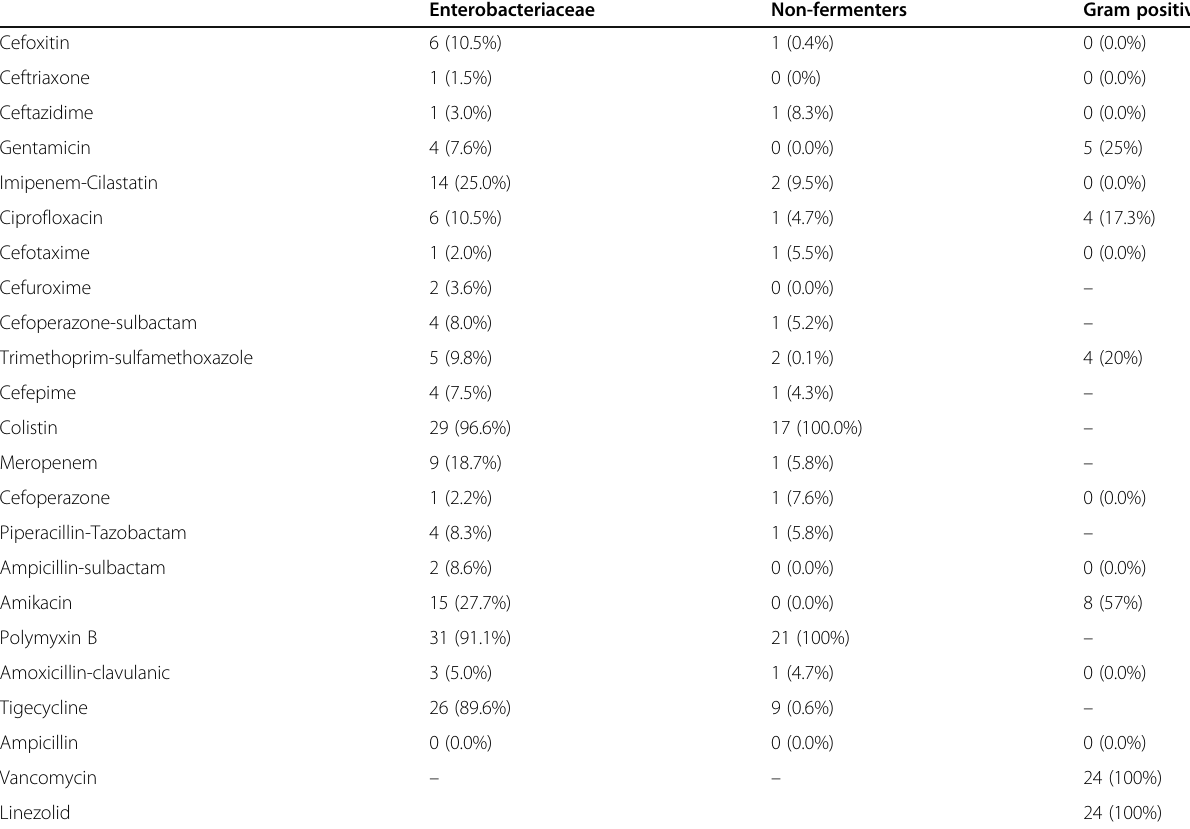
Table 5 Different antibiotic sensitivities of the 3 main bacterial families